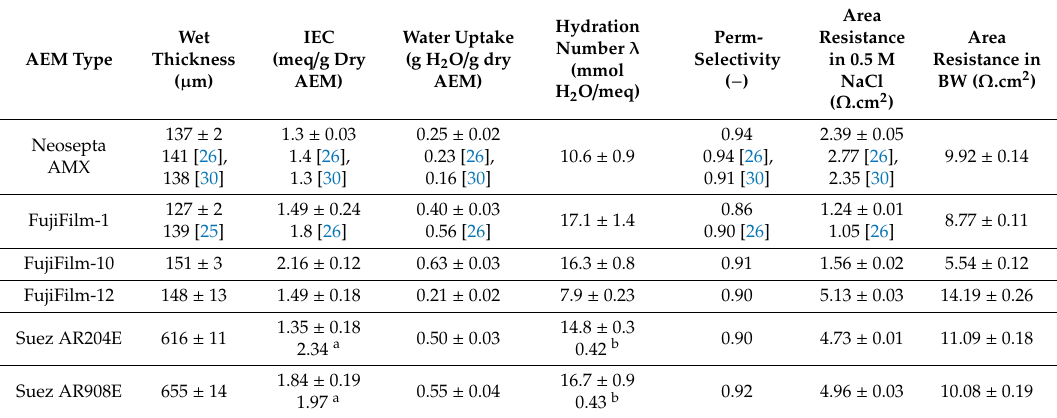
Table 5. Values measured and reported in the literature for membrane properties. Typical repeat errors for permselectivity are below